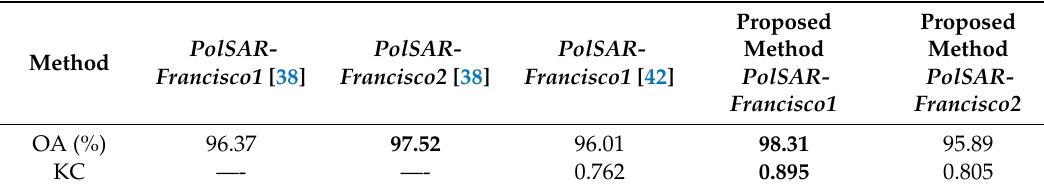
Table 15. Comparison between the accuracies of the CD methods for CD in the PolSAR datasets (italic characters are the name of